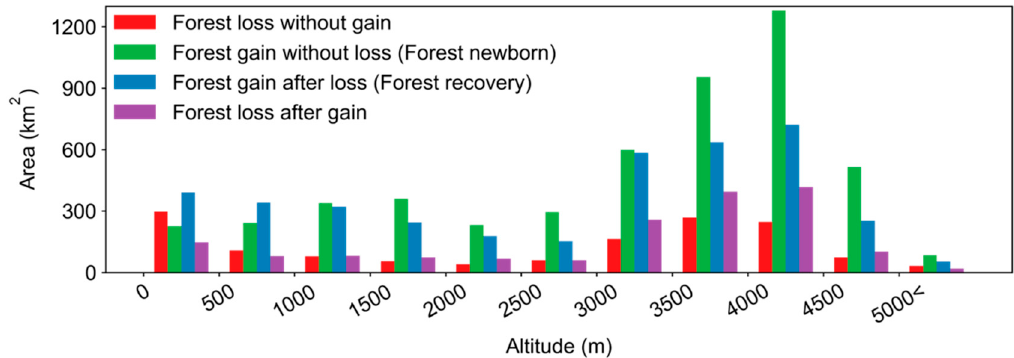
Figure 11. ( a ) Spatial distribution of four kinds of forest changes in 1990–2020 and area statistics along longitude ( b ) and latitude ( c ) of net gain.